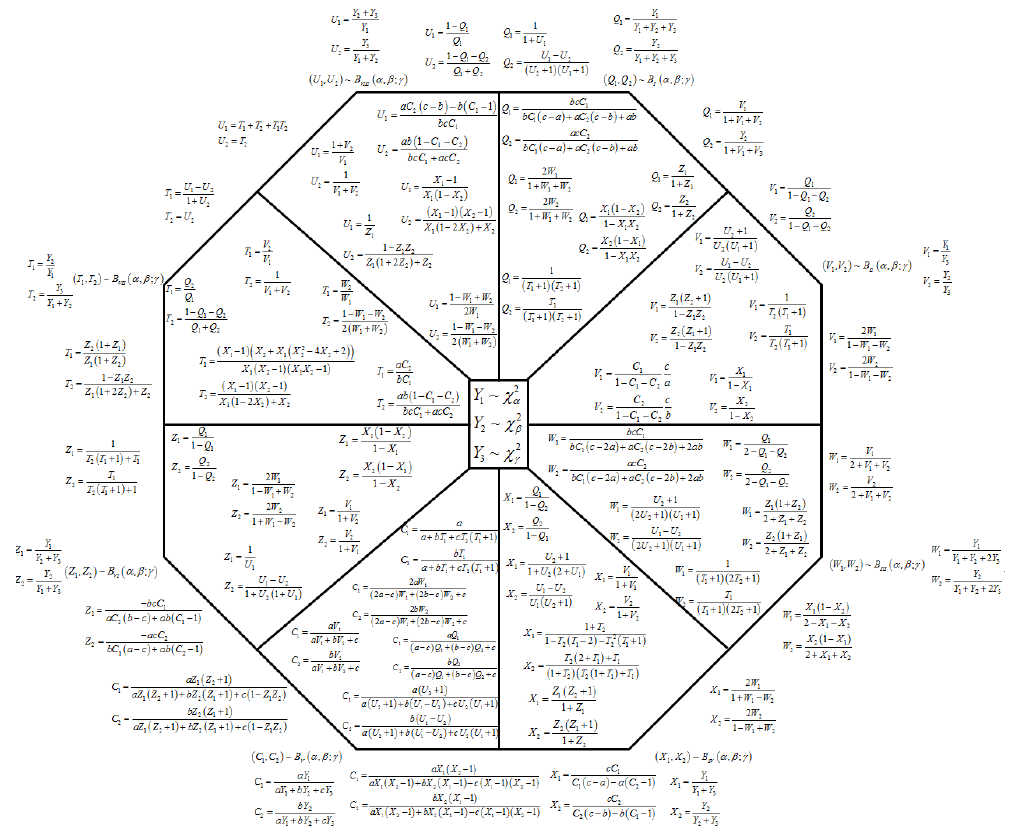
Figure A1. Relationships between several bivariate beta